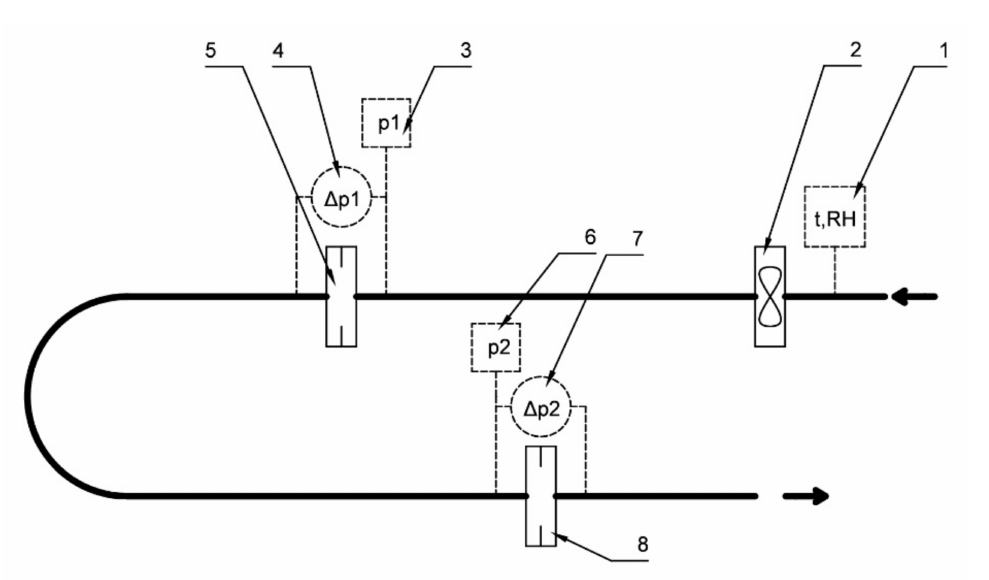
Figure 1. The experimental